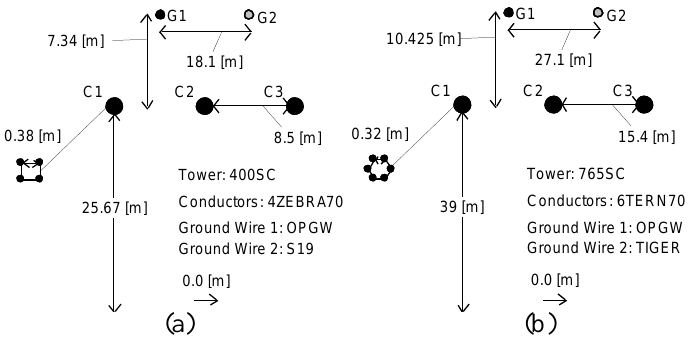
Figure 5. Tower geometry for the overhead lines: ( a ) 400-kV geometry and ( b ) 765-kV geometry.